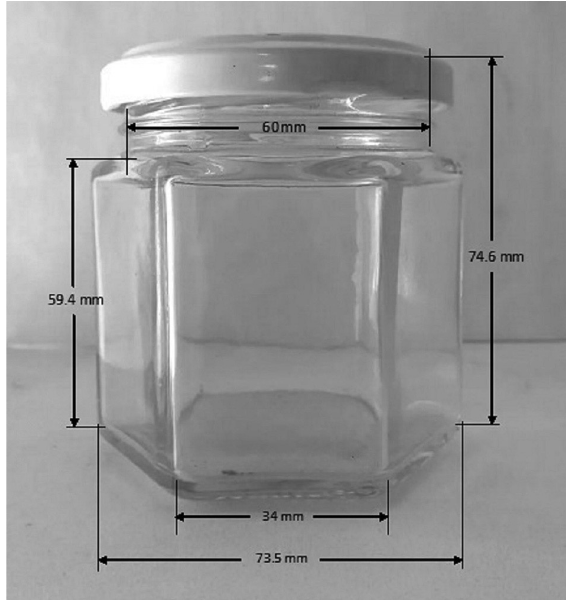
Figure 1. Hexagonal glass container with a half screw metal lid used to pack low-calorie Red Globe grape